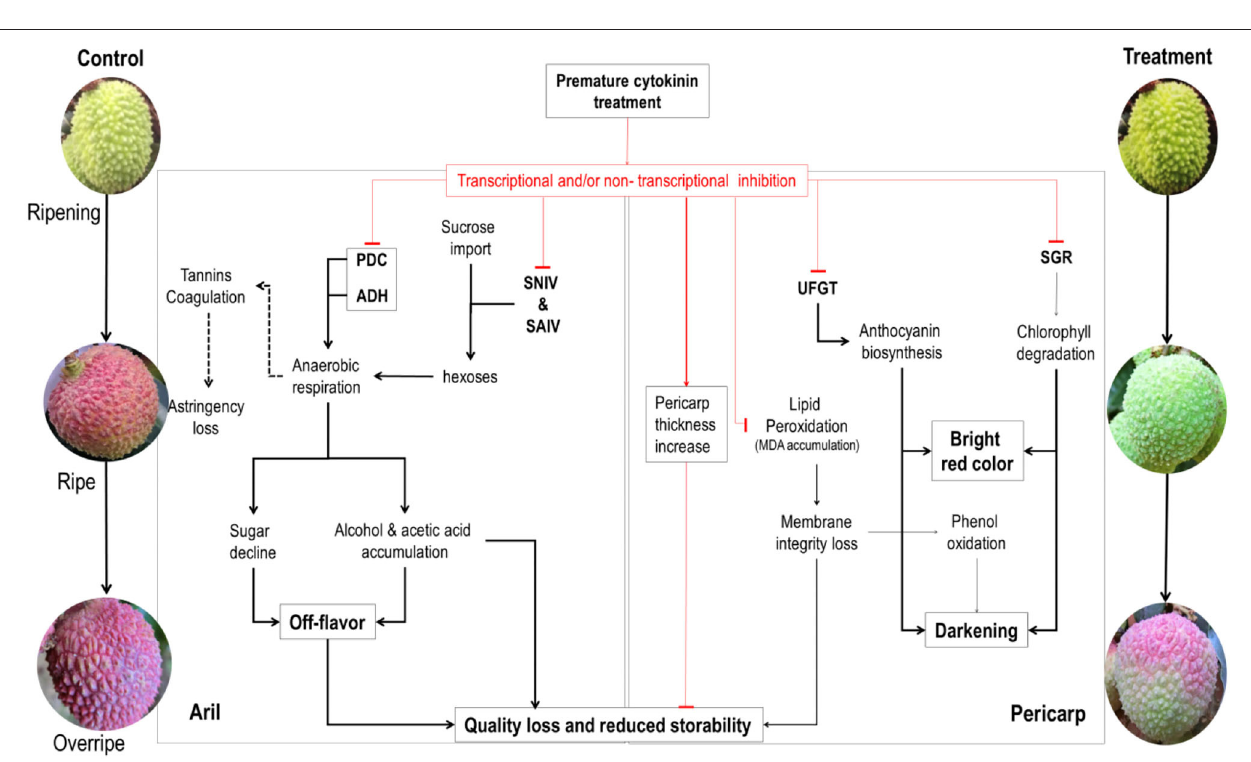
FIGURE 13 | Schematic mode of the effect of cytokinin on the physiochemical changes in the pericarp and the aril during maturation and senescence of litchi fruit on tree. The black lines with an arrow indicate the natural processes involved in fruit ripening and senescence. Dashed lines indicate effects to be proved. Red lines ended with a top bar indicate the inhibitory effect exerted by CPPU, whereas arrowed red line indicates promoting effect of CPPU. PDC, pyruvate decarboxylase; ADH, alcohol dehydrogenase; UFGT, flavonoid glucosyltransferase; UDPG, uridine diphosphoglucose; SGR, STAY-GREEN; SNIV, soluble neutral invertase; SAIV, soluble acid